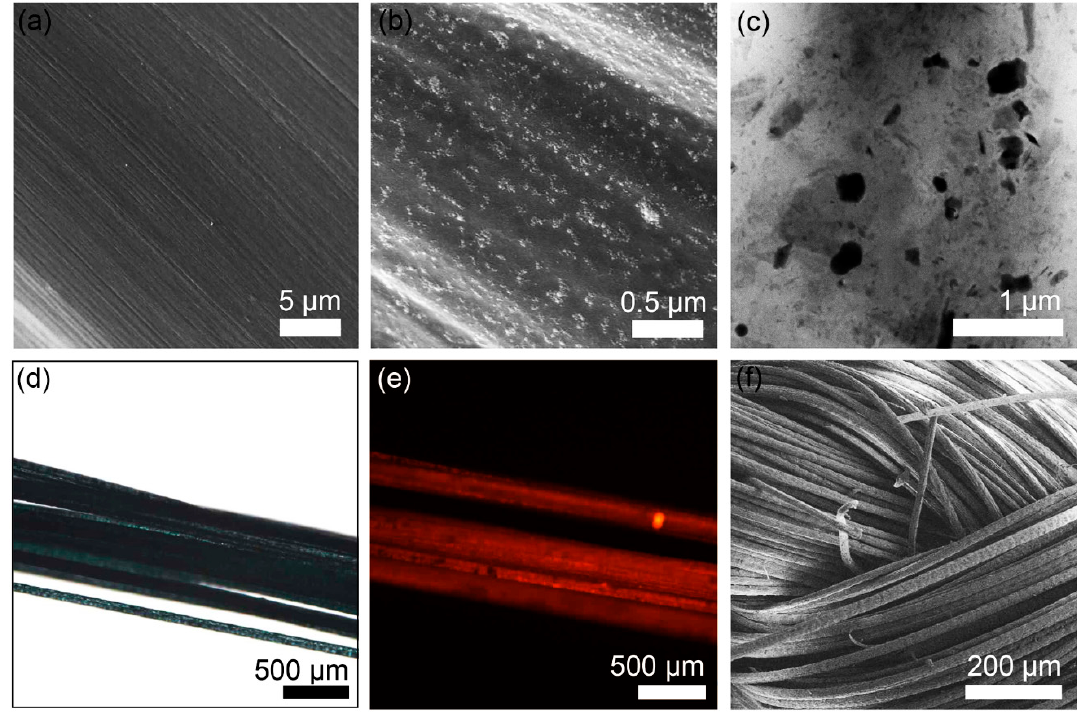
Figure 3. ( a ) SEM image of pristine PAN fiber. ( b ) SEM and ( c ) cross-sectional TEM images of a nanocomposite fiber of PAN with 0.75 wt % CPNs. ( d ) Optical and ( e ) fluorescent (excited at 650 nm) images of yarn based on nanocomposite fibers. ( f ) SEM image of fabric based on nanocomposite fibers.